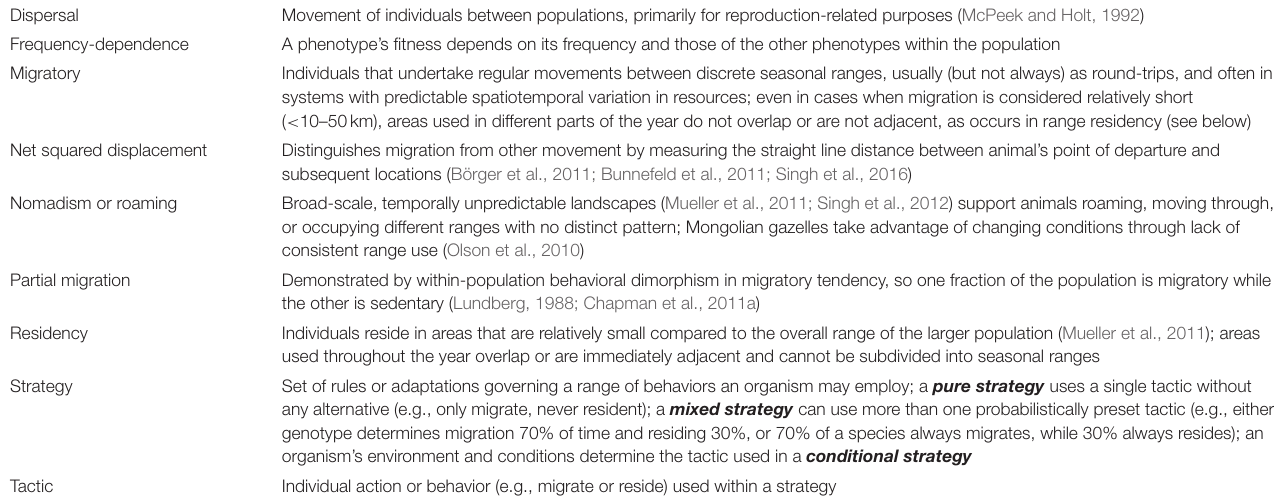
TABLE 1 | Definitions of words used in discussion of migration in ungulates. Dispersal